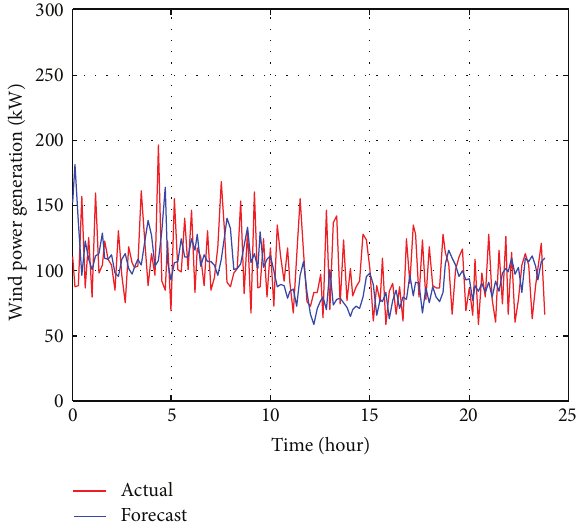
Figure 10: Test results with the back propagation neural network method for typical summer day.